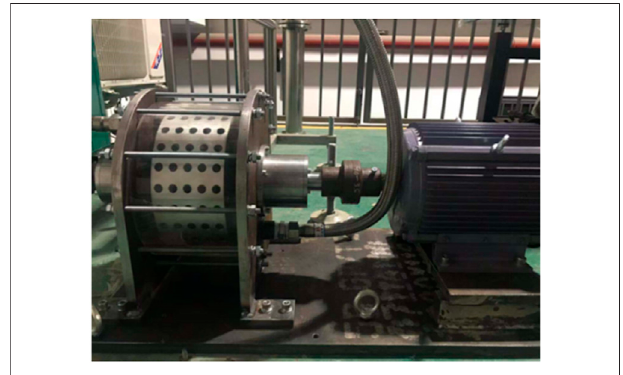
FIGURE 1 | Tested rotational hydrodynamic cavitation